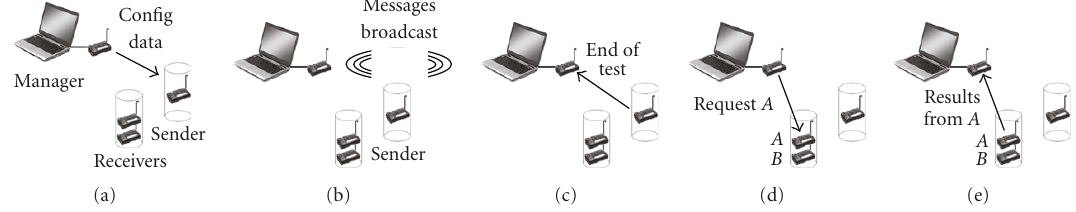
Figure 9: Software architecture of the WUSN testbed. (a) The manager sends the configuration to the sender. (b) The sender starts the experiment and (c) informs the conclusion. (d), (e) The manager captures the results.